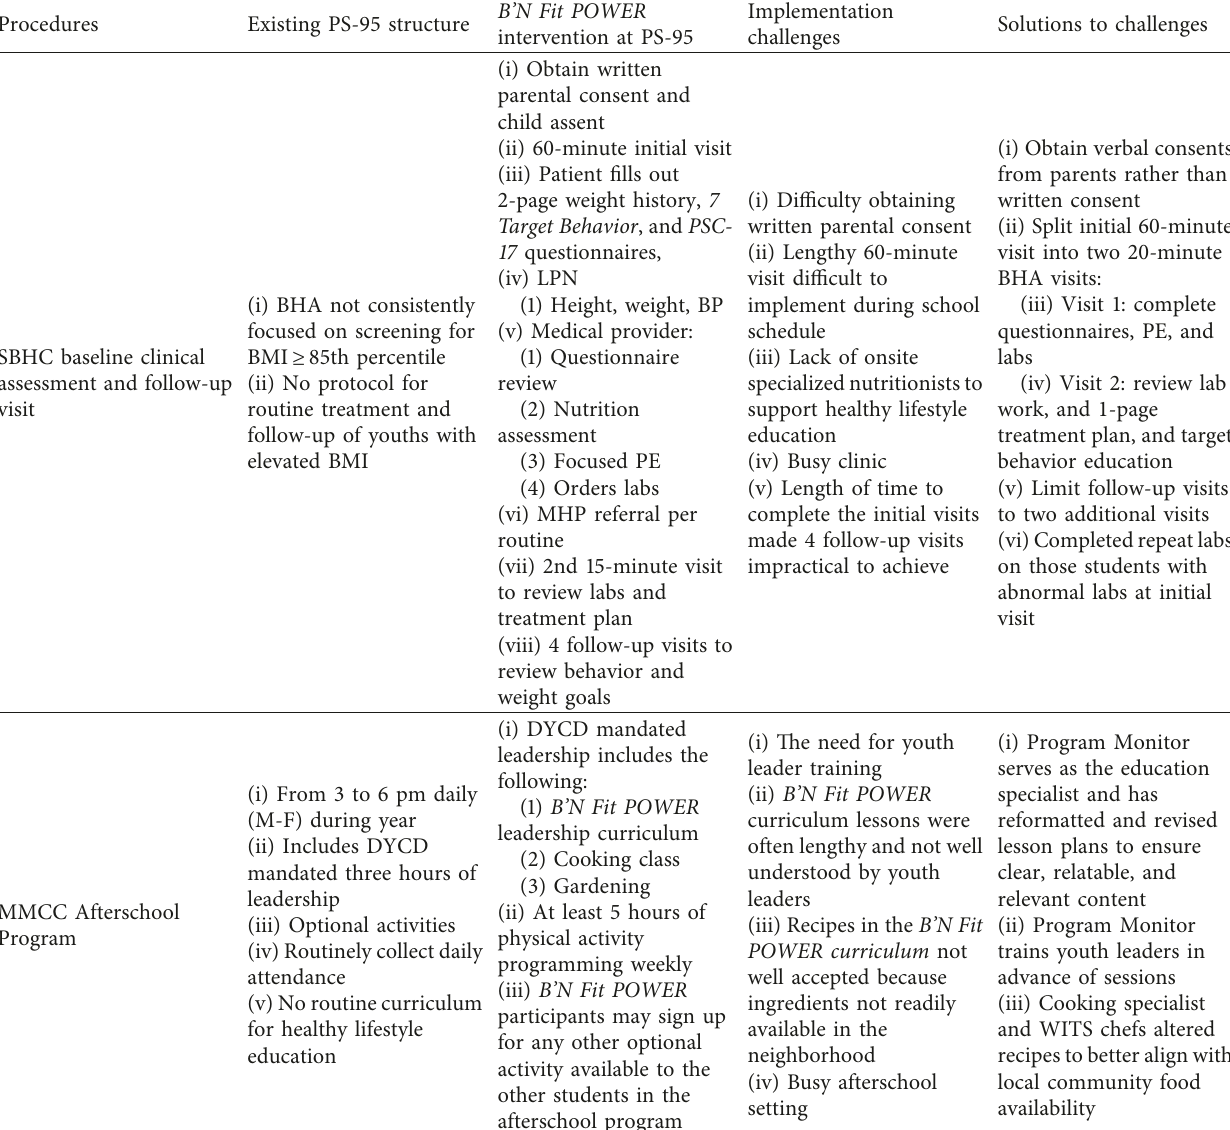
Table 5: B’N Fit POWER integration of SBHC visits and afterschool program